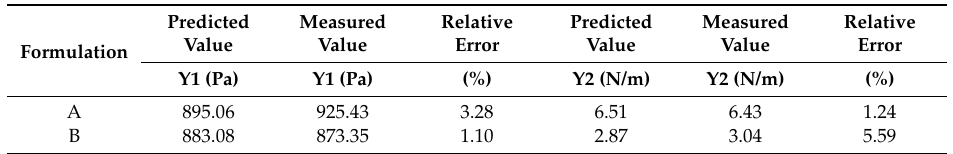
Table 4. Statistical comparison of predicted and measured results for Y1 and Y2 of optimized felbinac